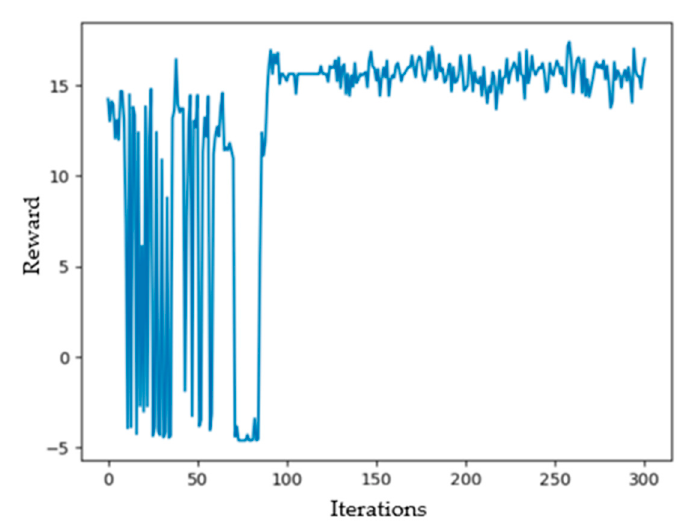
Figure 7. DQN cumulative rewards.